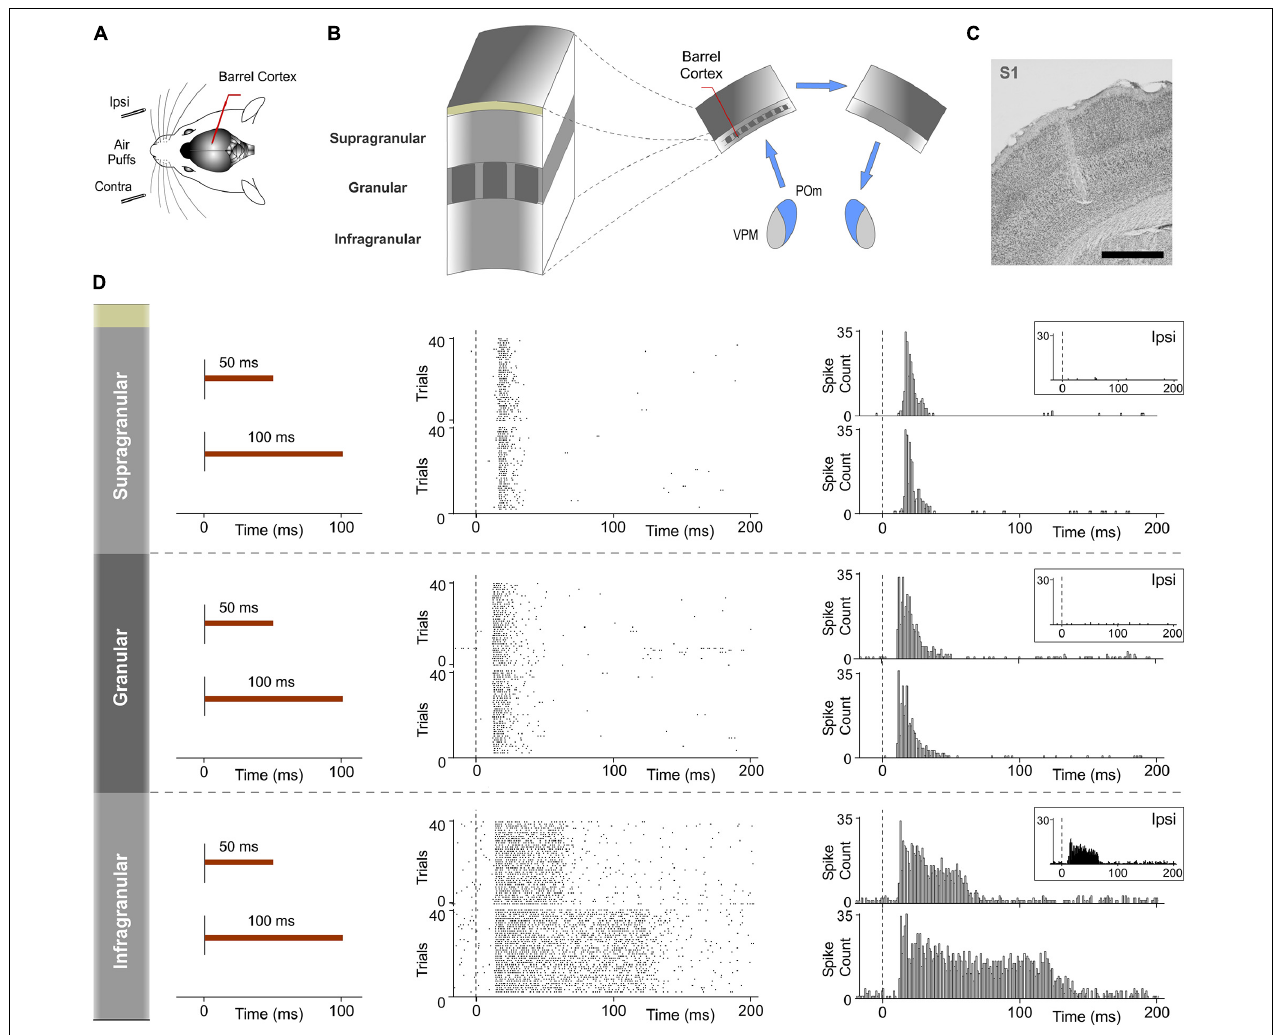
FIGURE 13 | Response modes differed between cortical layers in S1. Sustained responses along the stimulus presence were found in the infragranular layer but not in granular and supragranular layers. (A) Recordings were made in the barrel cortex in S1 using ipsi- and contralateral stimuli with different durations. (B) Evoked responses in supra-, granular, and infragranular layers of the barrel cortex were examined to study the laminar implication in the processing of sustained activity and its transmission across the POm-POm loop. (C) Histological section displaying the location of the sequence of recording sites across cortical layers in S1 and the track left by the electrode. Scale bar, 1 mm. (D) Raster plots and PSTHs showing representative responses in supragranular, granular, and infragranular layers evoked by contralateral stimuli with different durations. The mean onset latencies of these responses were 15.42 ± 0.22 ms (ranged from 12 to 25 ms, n = 117), 11.81 ± 0.21 ms (ranged from 8 to 15 ms, n = 88), and 12.67 ± 0.34 ms (ranged from 8 to 16 ms, n = 102), respectively. Note that evoked responses in granular and supragranular layers were transient just to the onset of stimuli and that they do not allow the discrimination between different durations of the same stimulus. Responses to ipsilateral stimuli were only found in the infragranular layer (insets). The mean onset latency of these responses was 17.82 ± 0.55 ms (ranged from 16 to 28 ms, n =